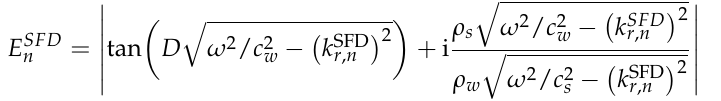
the characteristics of these two sound fields are identical.